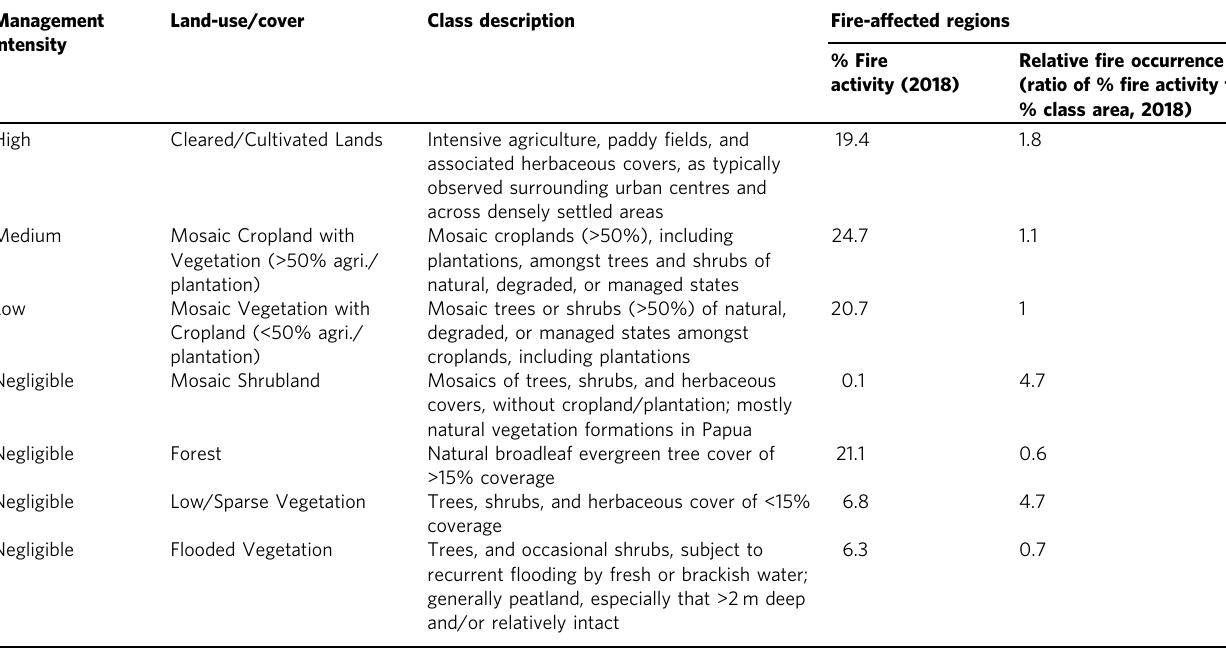
Table 1 Land use/cover classes and respective fractions of fi re activity in the fi re-affected regions of Indonesia. Management